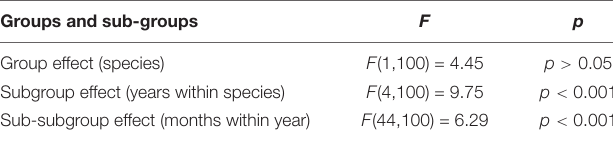
TABLE 4 | Three-level nested ANOVA (among-species difference as the group effect) for biomasses of D. polymorpha and D. rostriformis bugensis . Groups and sub-groups F